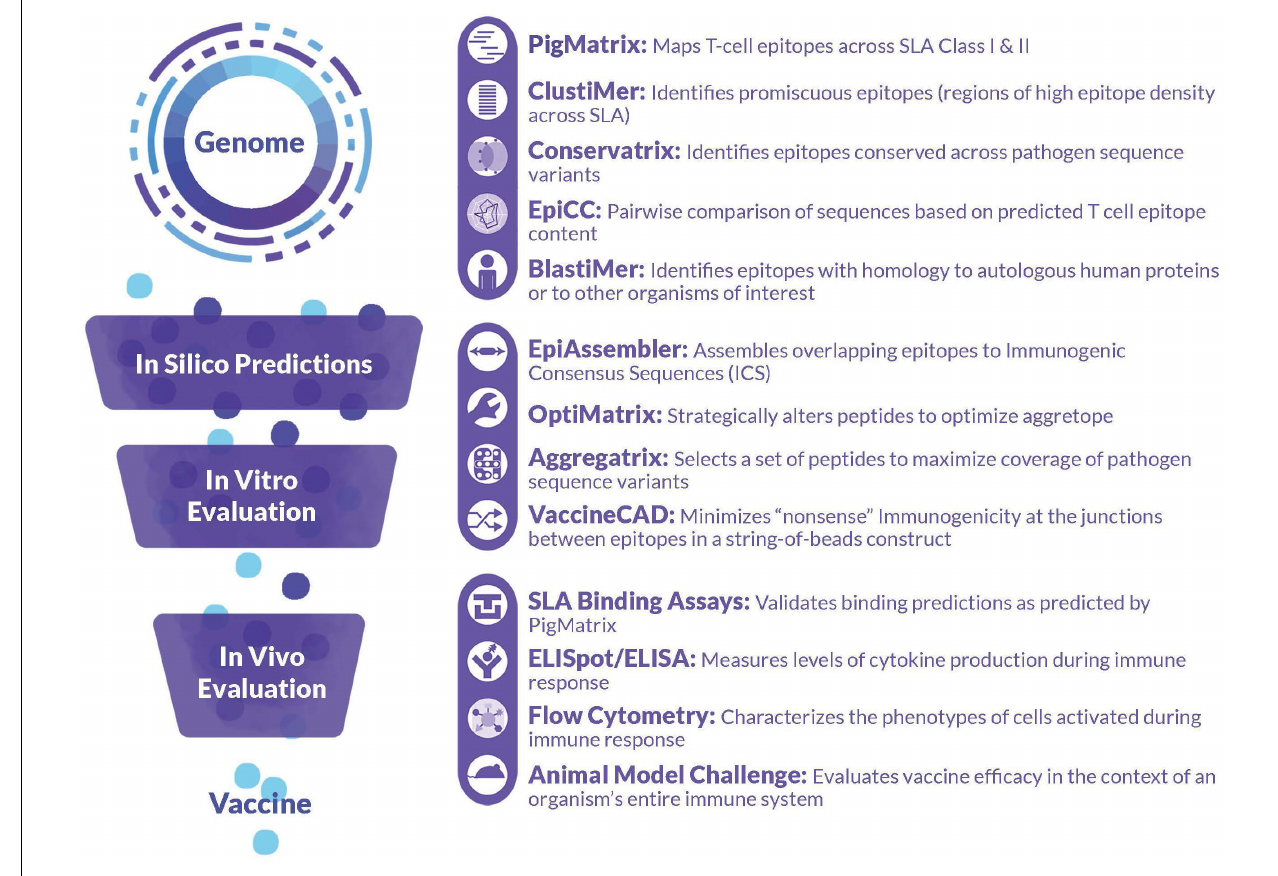
Frontiers in Immunology |